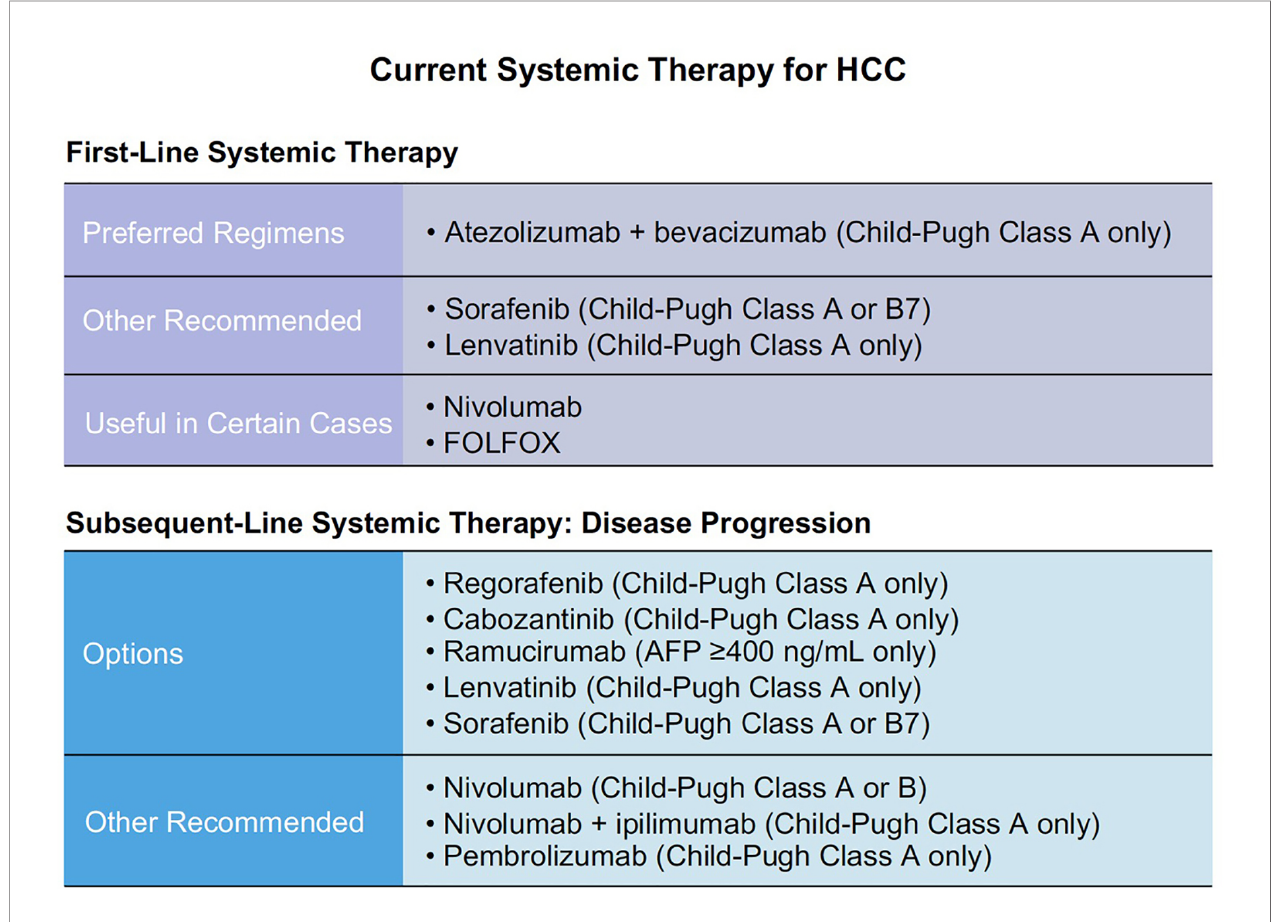
FIGURE 1 | Current systemic therapies for